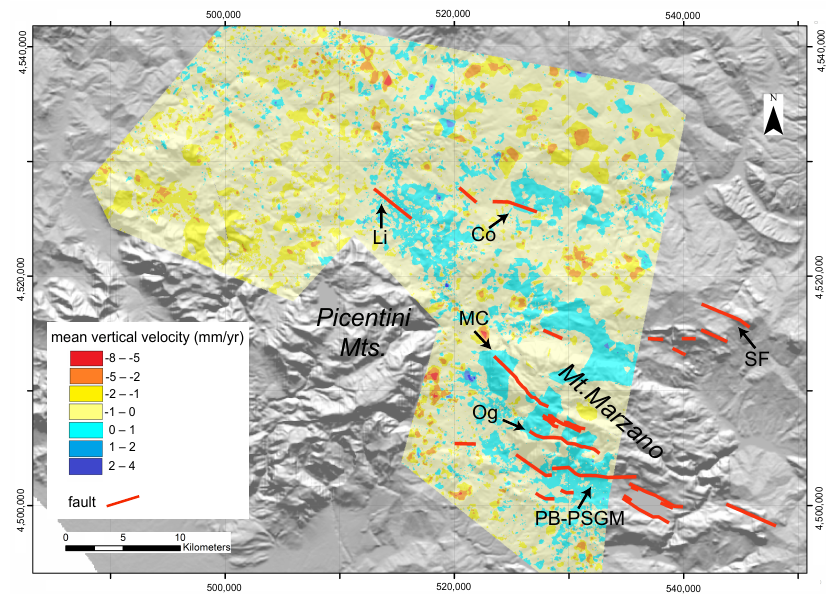
Figure 9. IDW interpolation (cell 50 × 50 m) of ENVISAT PS ‘native’ datasets (i.e., the datasets that include both normal and outlier PSs), showing the vertical mean velocity / ground deformation in the 2003–2010 timespan. Fault / fault array labelling as in Figure